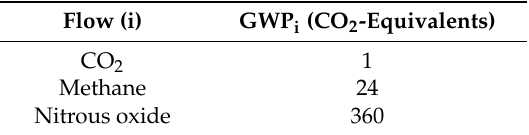
Table 3. BEES GWP correspondence factors